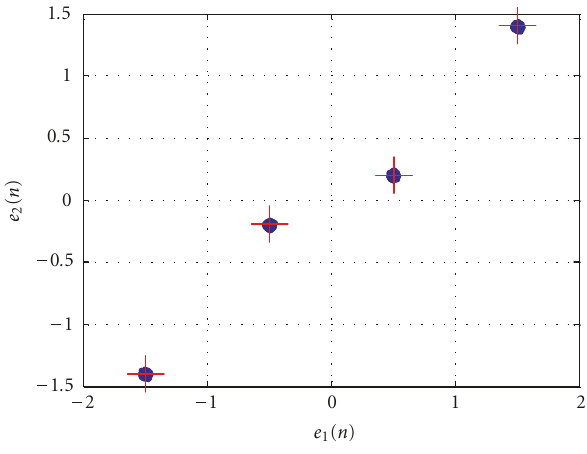
Figure 6: Joint distribution of the error-prediction filters outputs; (+) indicates the joint distribution of the corresponding instanta- neous problem (14).